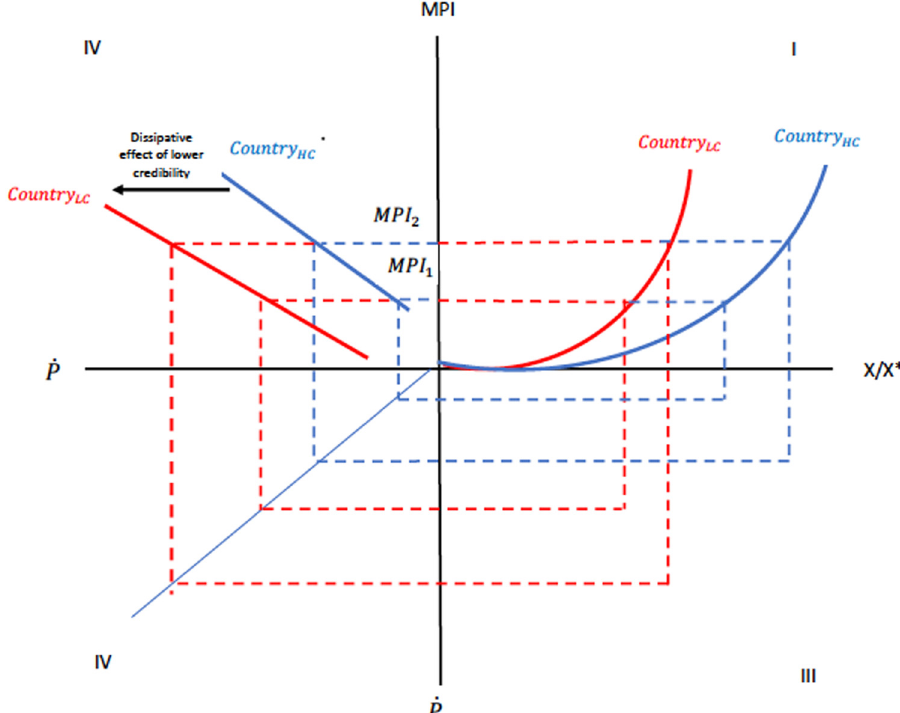
Figure 2: Policy shocks and credibility. Note: The responses of real output ( as a proportion to potential output ) X / X * to policy shocks MPI 1 and MPI 2 are represented by the two schedules charted in quadrant I of Figure 2 for high - credibility Country and low - credibility Country , LC HC respectively. As discussed in Section 6, the variable called MPI re fl ects the combined monetary and fi scal policy shocks to aggregate demand. The position of the two schedules indicates the higher e ff ectiveness of policy shocks ( in terms of output changes ) in the high - credibility country. Symmetrically, policy shocks are relatively less e ff ective ( in terms of output changes ) in the low - credibility country, where they dissipate instead into higher rates of in fl ation. The in fl ation response P ̇ to changes in MPI are represented by the two schedules charted in quadrant IV of Figure 2 for high - credibility Country and low - credibility Country , respectively. The position of the two schedules LC HC indicates the higher dissipation of the policy shocks ( in terms of higher in fl ation ) in the low - credibility country. The di ff erent colors used for the two countries are used to track their respective output and in fl ation responses to policy shocks, through the